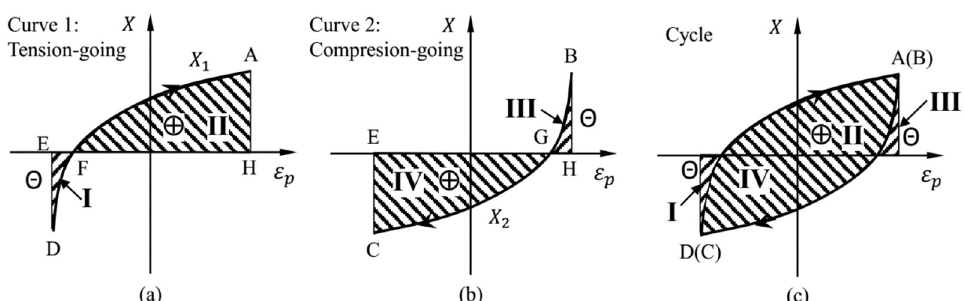
Figure 8. The accumulation and dissipation of plastic work of back stress during cyclic loading. ( a ) Curve1: Tension-going; ( b ) Curve2: Compression-going; ( c ) Closed loop. The symbol ⊕ represents the positive area, while the symbol ㊀ represents the negative area.